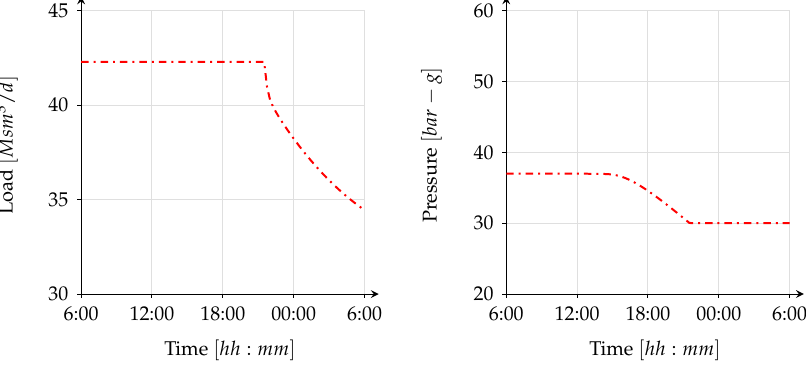
Figure 17. Load and pressure profile of CBE_1 for scenario